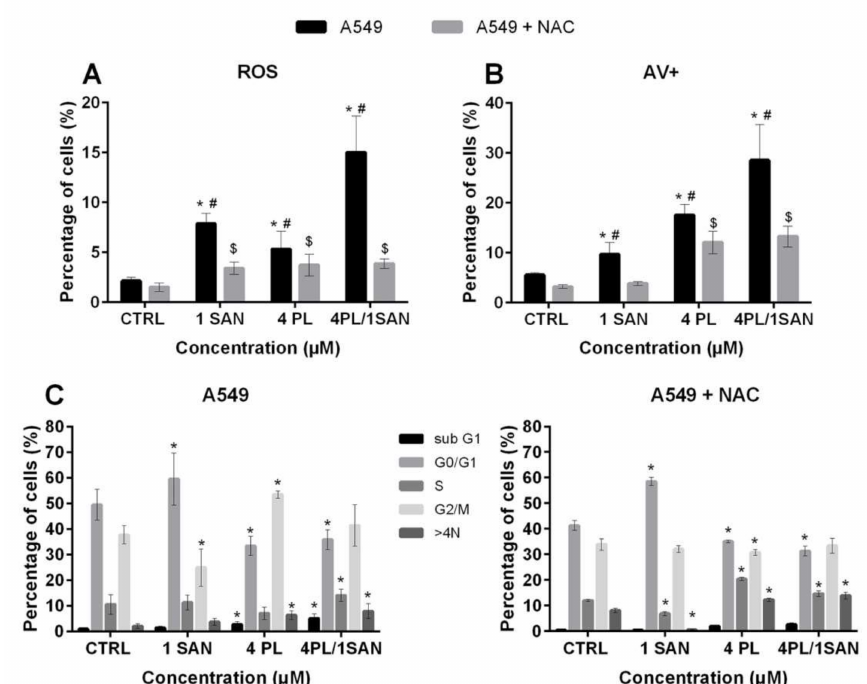
Figure 7. The synergistic e ff ect of the alkaloids combination is related to the reactive oxygen species (ROS). Cells were treated for 24 h with PL at concentrations 1–8 µ M; SAN at doses of 0.25, 0.5, 1, 1.5 and 2 µ M and their combination in ratio 4:1. To inhibit ROS induction, A549 cells were preincubated for 2 h with 5-mM N -acetyl- l -cysteine (NAC) and then treated with alkaloids for 24 h. ( A ) The results obtained are presented as the percentage of ROS-positive cells relative to the sample size. ( B ) The comparison of results from the AV / PI assay for cells without (A549) and preincubated with NAC (A549 + NAC). Statistical significance was marked with * for the comparison between A549 cells without and with the preincubation with NAC, # for A549 cells without incubation with the ROS inhibitor in comparison to the CTRL and $ A549 cells with the addition NAC compared to untreated cells ( p < 0.05; two-way ANOVA). ( C ) Cell cycle analysis for A549 and A549 + NAC. Data represent the mean ± SD obtained from 4 independent replicates ( n = 4). Statistically significant di ff erences in comparison to the untreated cells were marked as * ( p < 0.05; two-way